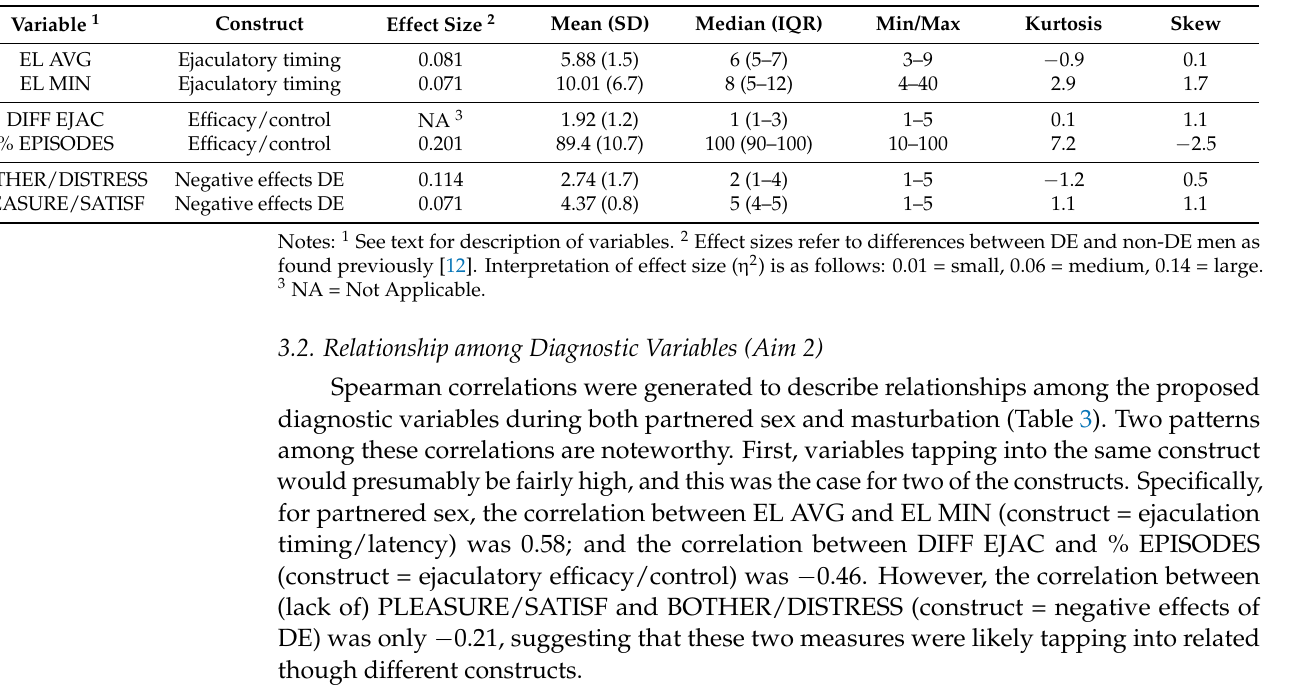
Table 2. Proposed face-valid items for use as diagnostic measures for delayed ejaculation.